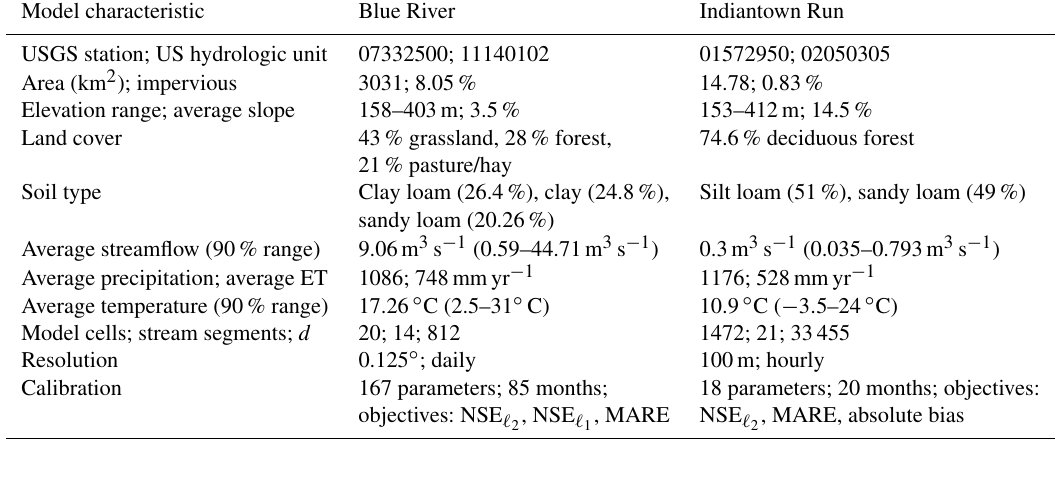
Table 3. Characteristics of the two test watersheds: Blue River and Indiantown Run. US hydrologic units are defined in Seaber et al. (1987). Elevation information was obtained from the Shuttle Radar Topography Mission (Rodríguez et al., 2006); land cover and impervious per- centage from the National Land Cover Database, NLCD (Homer et al., 2012); soil type from CONUS-SOIL (Miller and White, 1998); and precipitation, evapotranspiration, and temperature from NLDAS-2 (Cosgrove et al., 2003). The streamflow and temperature include their range of variation of 90% of the time (5% tails at the high and low end are excluded).